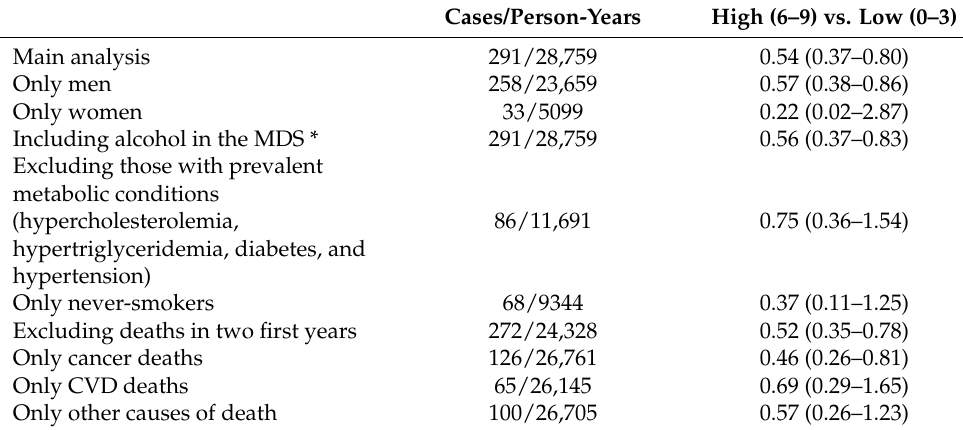
Table 3. Sensitivity analyses: Association of high adherence to MADP score and total mortality under a diversity of